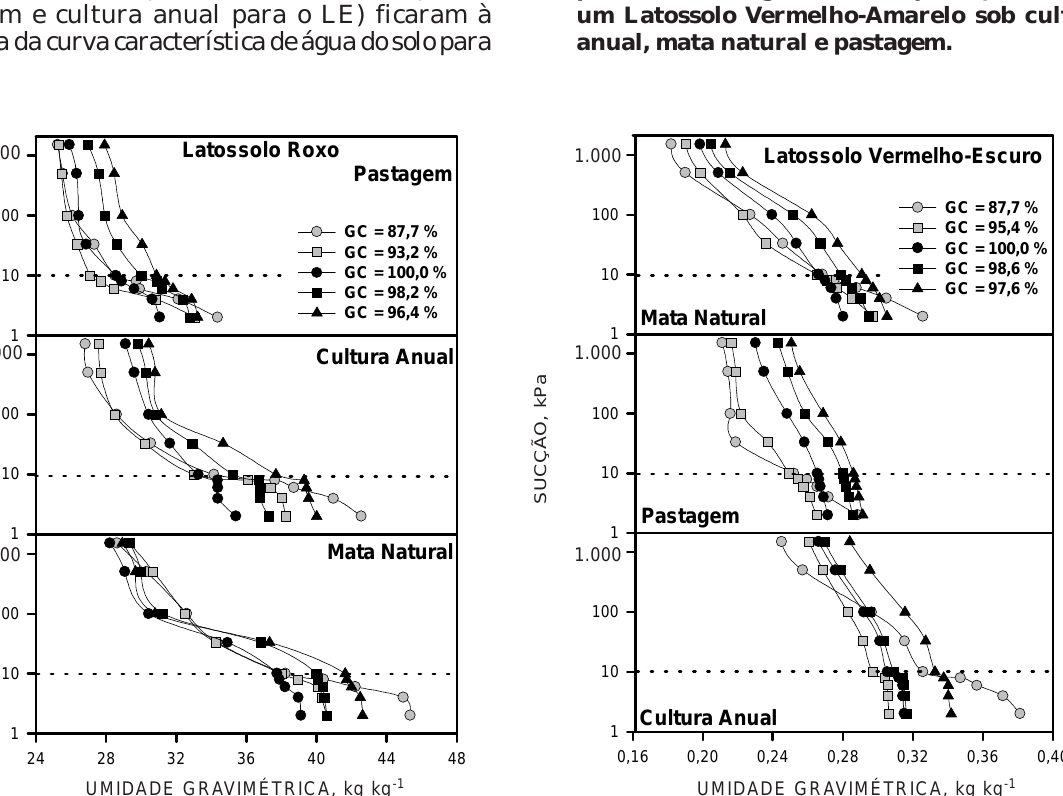
Figura 4. Curvas características de água do solo para diferentes graus de compactação (GC) de um Latossolo Vermelho-Escuro sob cultura anual, mata natural e